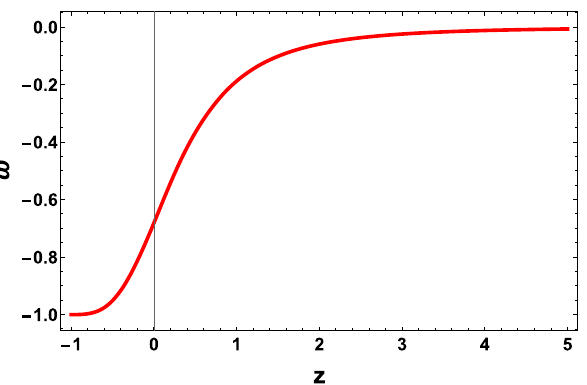
Fig. 5 Variation of EoS parameter for the best fitted value of m = 0 . 47 and n = 3 . 2 from the analysis of SNeIa Pantheon